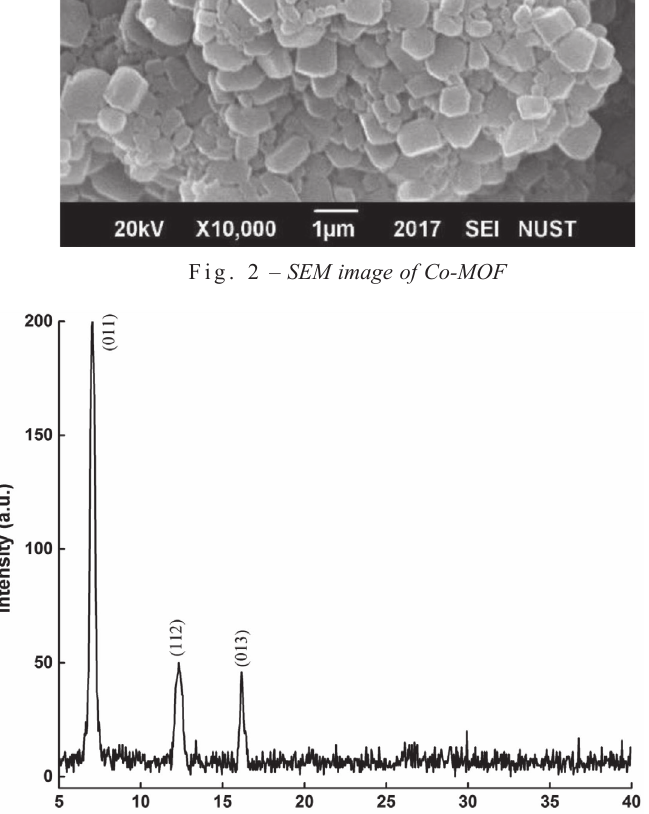
Fig. 3 – X-ray diffractogram of Co-MOF